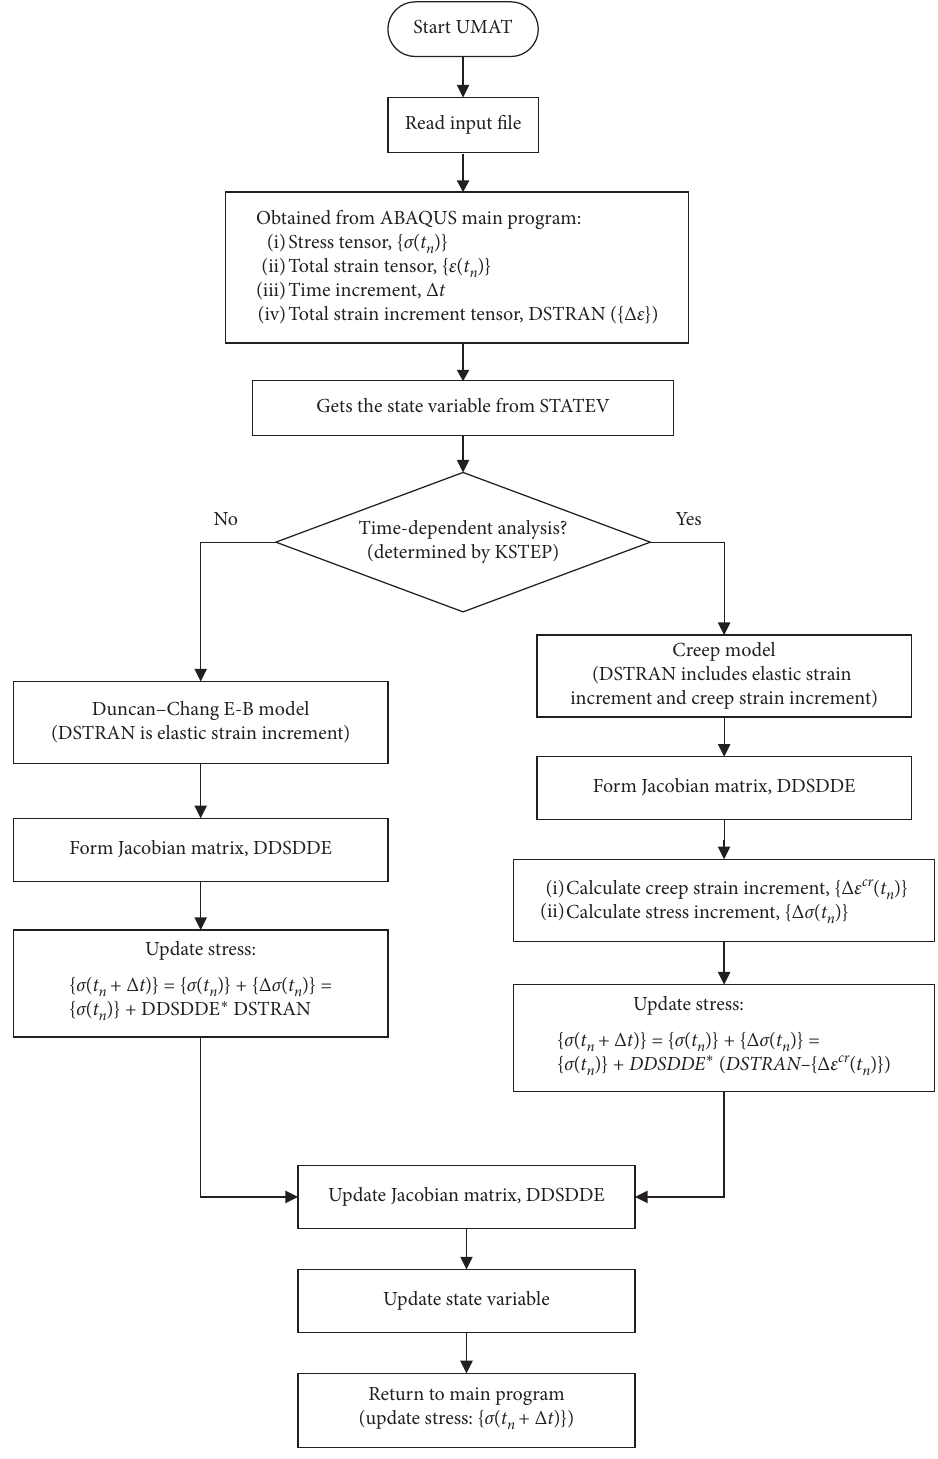
Figure 1: The UMAT algorithm flowchart for creep analysis in